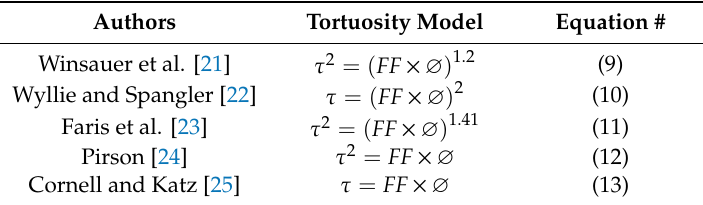
Figure 23. Pore network model for samples C24 and A83. The color legend represents the pore and throats sizes, where dark blue represents small pores and throats, and red represents big pores and throats. Table 3. Di ff erent electrical tortuosity